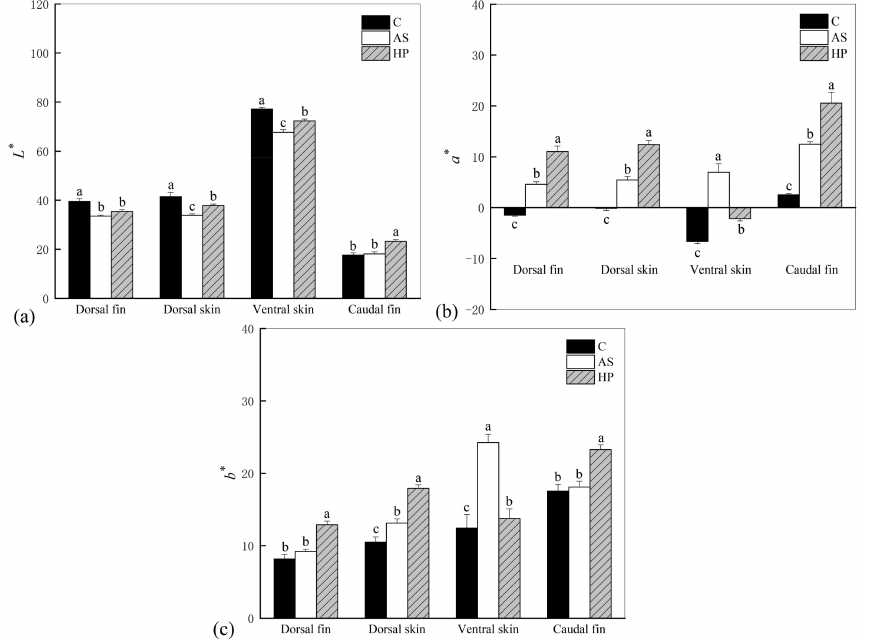
Figure 1. Color parameters of P. leopardus after 14 weeks of feeding experimental diets supplemented with different sources of astaxanthin. ( a ) L * indicates brightness—the larger the value, the brighter the body color; ( b ) a * indicates red coloration—positive values represent reddish and negative values represent greenish; ( c ) b * indicates yellow coloration—positive values represent yellowish and negative values represent blueish. Data are presented as mean ± SD. Different letters indicate difference ( p < 0.05) among groups. The letter C is control, AS is synthetic astaxanthin, HP is natural